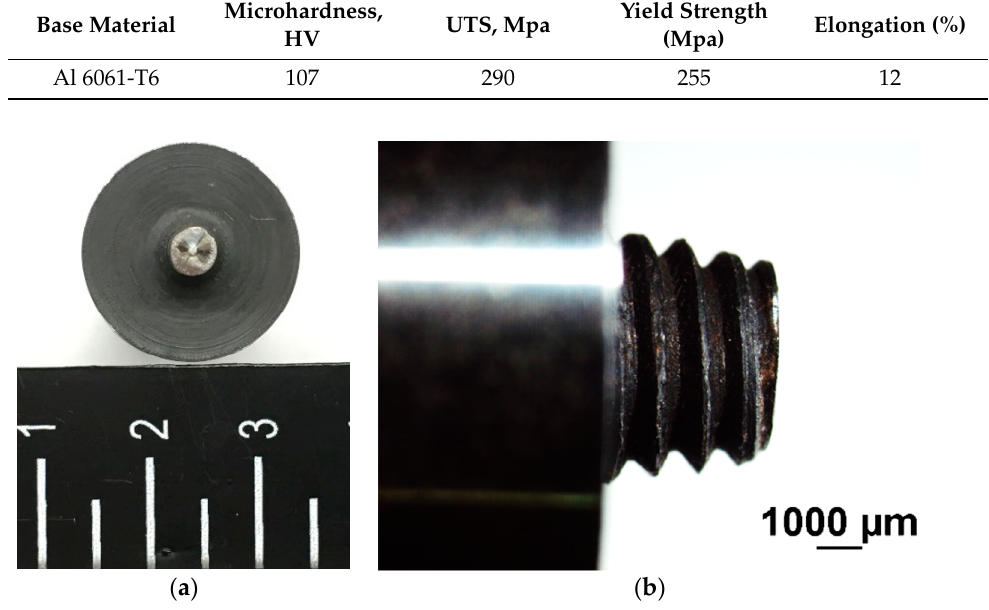
Figure 12. Tool 1 design: ( a ) shoulder and ( b ) pin.